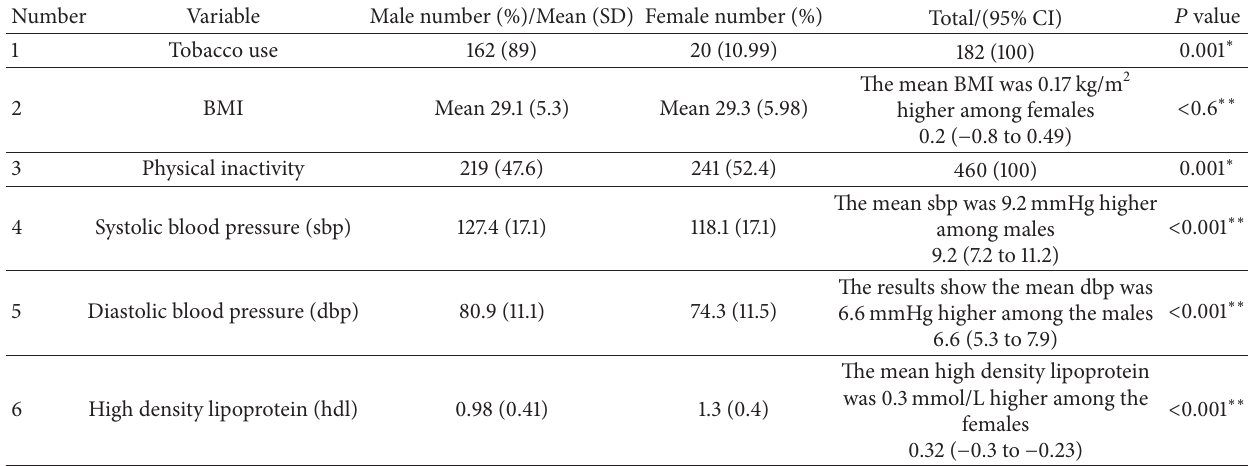
Table 4: Comparison of some risk factors between genders among the